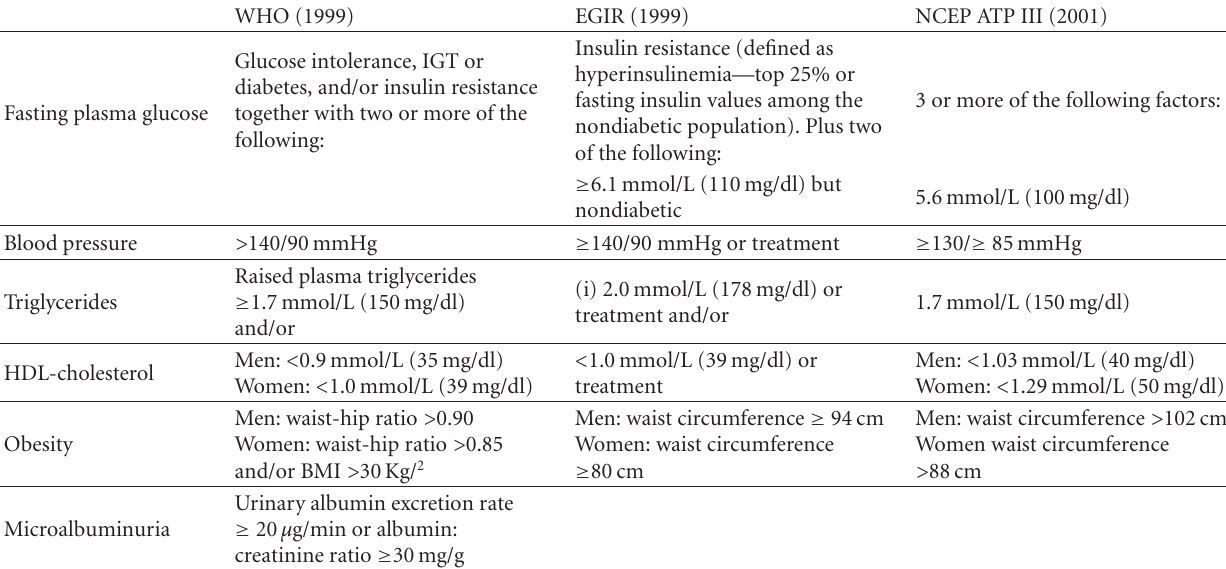
Table 1: Principal metabolic syndrome definitions.